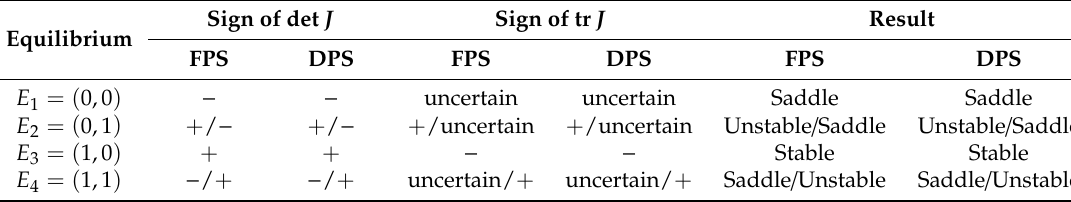
Table 4. Situation 2: local stability of equilibrium.